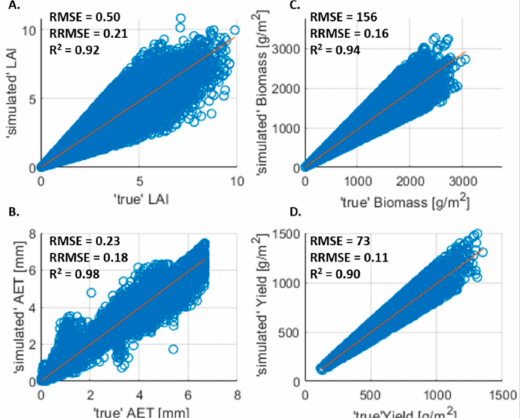
Figure 8. Comparison of “true” and “simulated” variable obtained using the EnKF-SAFY_swb data assimilation method for a synthetic dataset (6 assimilated observations). A set of 5000 simulations is used. For each variable RMSE, relative RMSE and R 2 are shown. In detail: ( A ) comparison and linear regression between “true” and “simulated” LAI; ( B ) comparison and linear regression between “true” and “simulated” actual evapotranspiration; ( C ) comparison and linear regression between ) ; ( D ) comparison and linear regression between “true” and “simulated” biomass (expressed in g m 2 “true” and “simulated” yield (expressed in g ). m 2